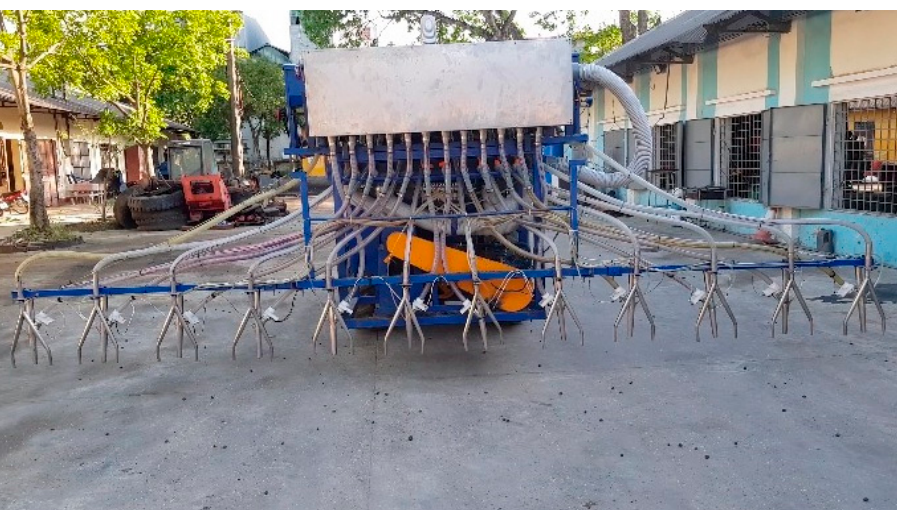
Figure 1. Image of an air-assisted rice seeder.